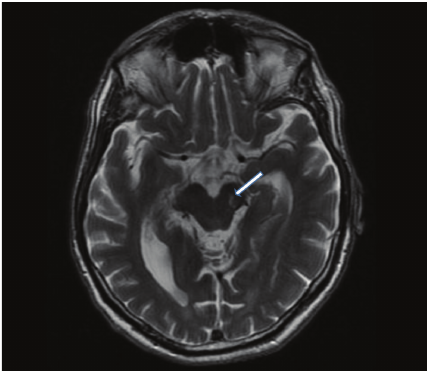
Figure 1: Cranial MRI revealed a lacunar infarction localized in the left midbrain (arrow) appearing hyperintense in T2 sections.